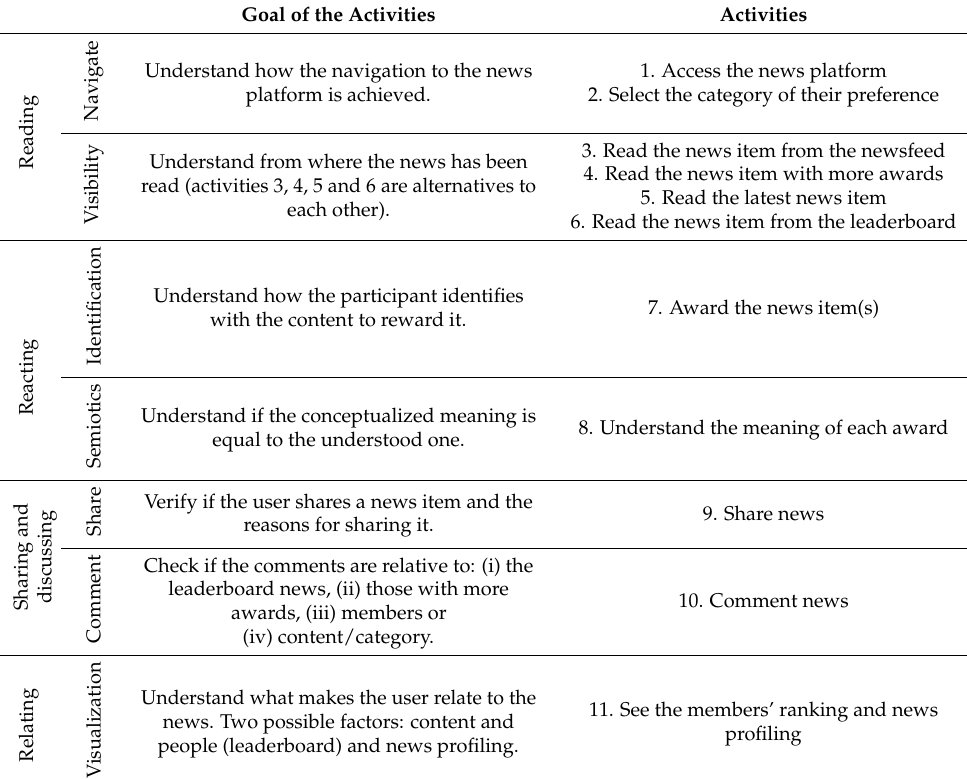
Table 4. Activities to be performed during the evaluation test. Retrieved from Gamifying News for the miOne Online Community (Regalado